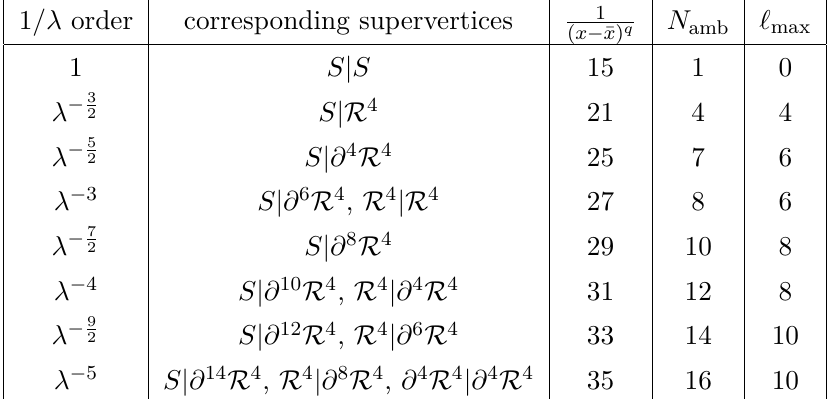
(linear combinations of) D -functions with their ( x − ¯ x ) denominator power bounded by the corresponding denominator in the ansatz for A